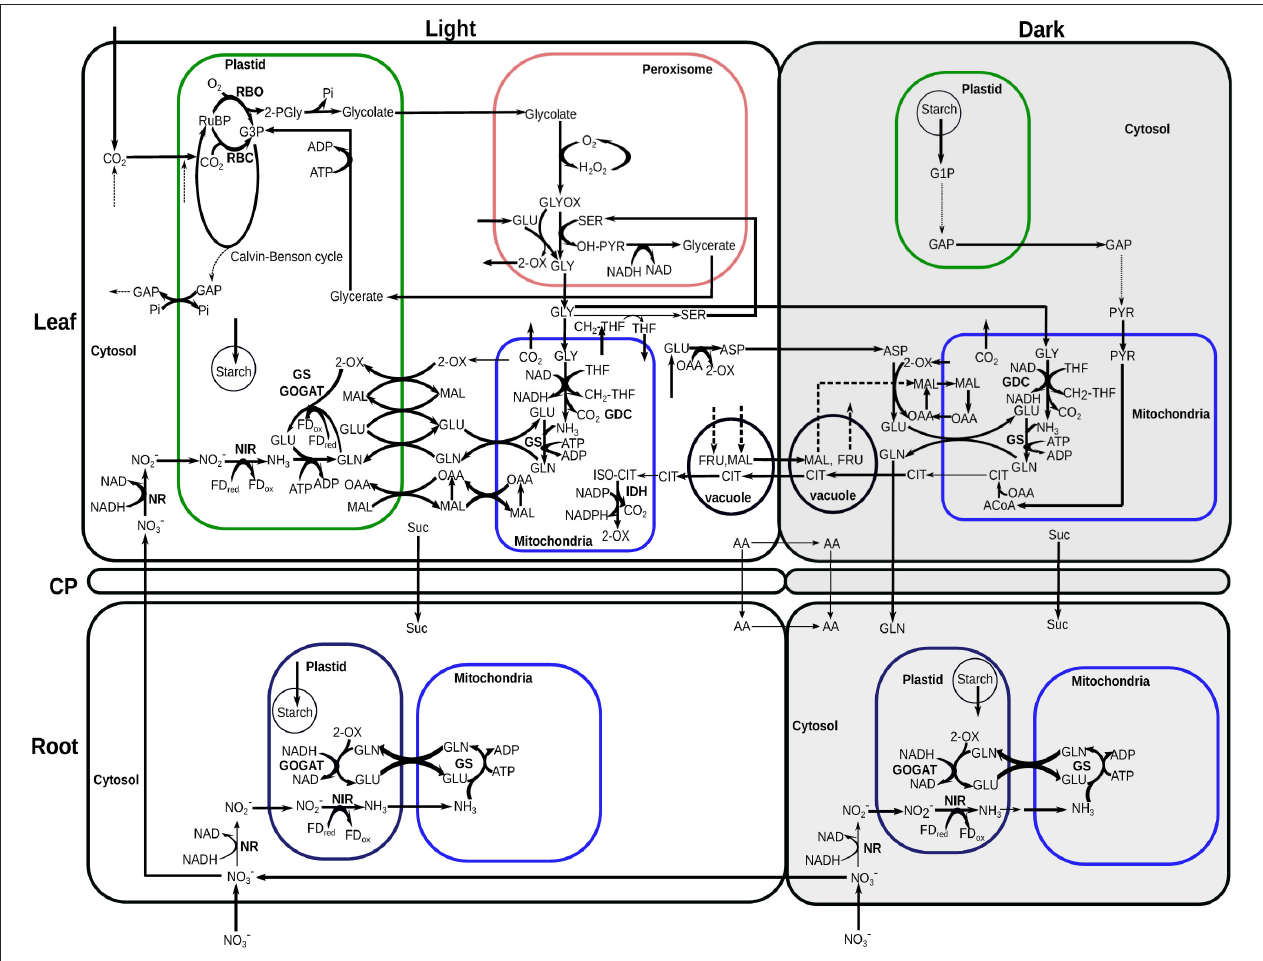
FIGURE 4 | Central carbon and nitrogen metabolism of Arabidopsis thaliana active in most growth stages and conditions simulated. Full Calvin-Benson cycle was active in leaf during the light phases. A complete TCA cycle was mainly active at the dark phases of leaf and in light and dark phases of root. Full oxidative pentose phosphate pathway reactions were active at the dark phases in leaf plastid and in light and dark phases of root plastid. These pathways were omitted from the flux map for clarity. The thickness of the arrows is not scaled to relative flux magnitudes. Bold lines indicate reactions identified as essential by FVA under most of the growth days. RuBP, ribulose-1,5-bisphosphate; G3P, 3-phosphoglycerate; 2-PGly, 2-phosphoglycolate; GAP, glyceraldehyde 3-phosphate; Pi, inorganic phosphate; 2-OX, 2-oxoglutarate/ α -ketoglutarate; GLU, glutamate; GLN, glutamine; OAA, oxaloacetate; FD ox , oxidized-ferredoxins; FD red , reduced-ferredoxins; NO − 2 ,